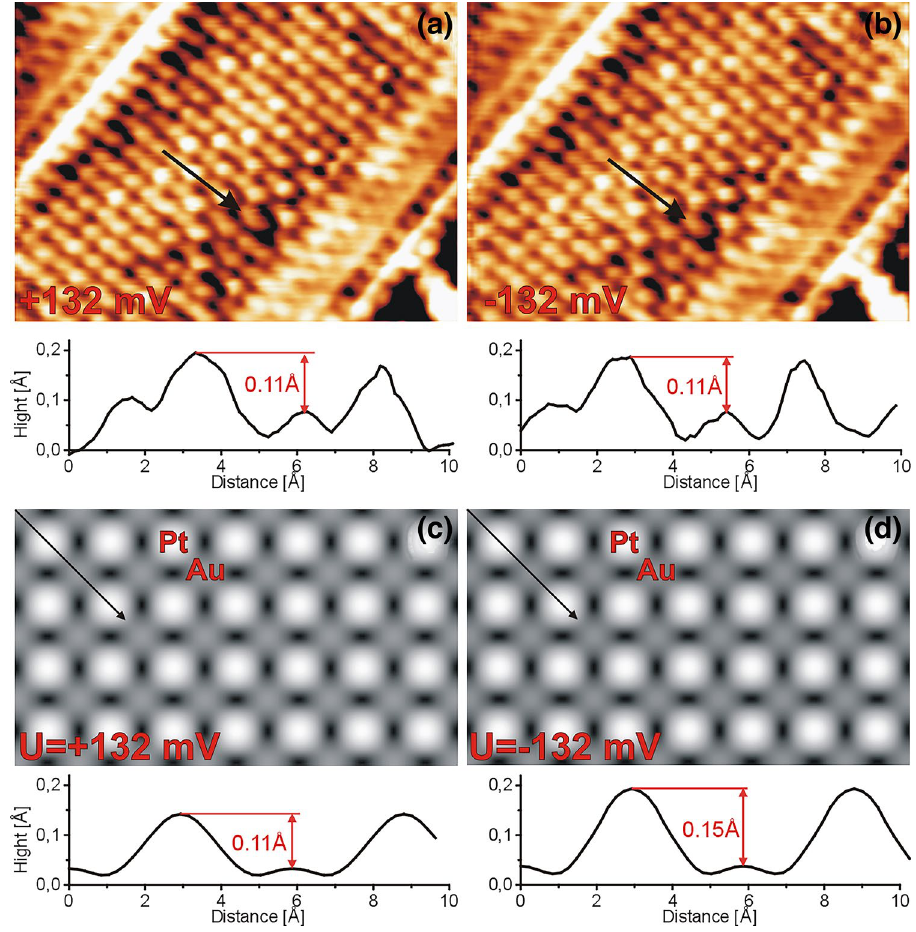
Figure 4. Comparison of STM images of c(2 × 2) structure taken for (a) U = + 132 mV; I = 8.7 nA and (b) U = −132 mV; I = 8.7 nA with the calculated images for (c) U = + 132 mV and (d) U = − 132